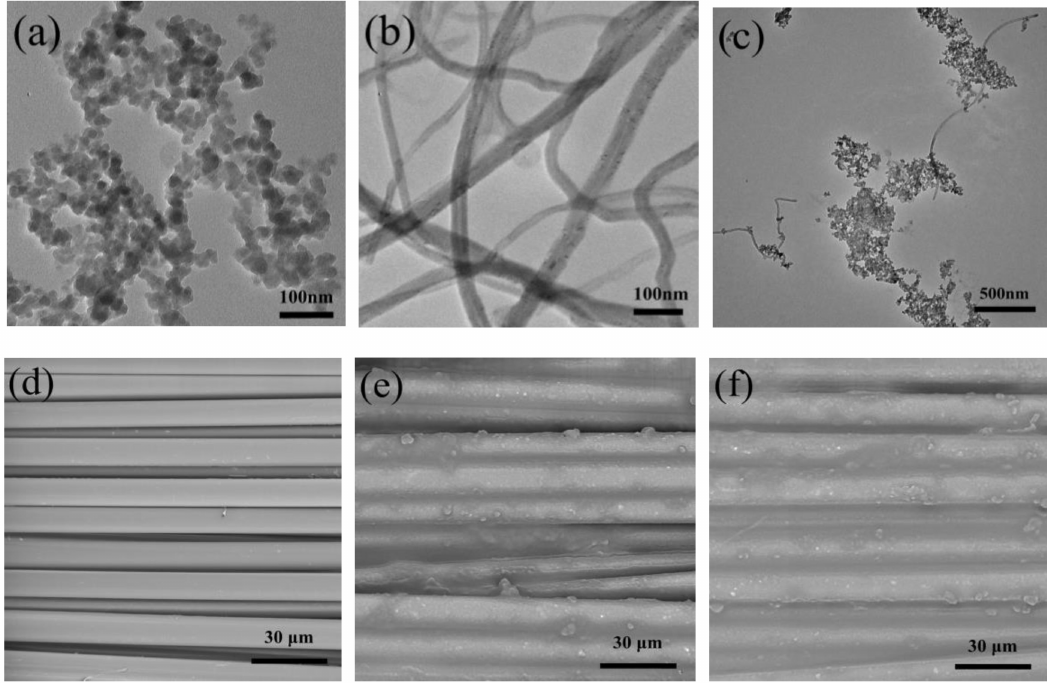
Figure 1. TEM images of ( a ) fumed silica nanoparticles, ( b ) O 2 -plasma treatment MWNTs and ( c ) fumed silica nanoparticles and M-MWNTs, SEM images of ( d ) neat Kevlar fabric, ( e ) STF/Kevlar fabric, and ( f ) M-MWNT/STF/Kevlar